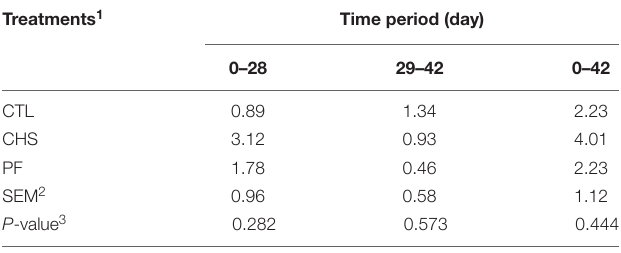
TABLE 3 | Effect of rearing temperature and feed restriction on mortality (%) of Cobb 500 male broiler chickens. Treatments 1